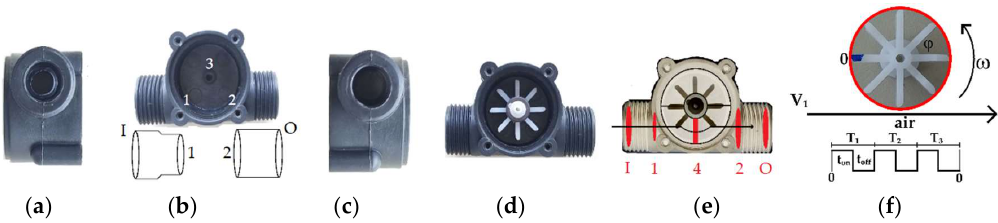
Figure 1. YF-S201 flow sensor: ( a ) Input profile; ( b ) Control volume; ( c ) Output profile; ( d ) Propeller compartment; ( e ) Airflow profile; ( f ) Detail of the propeller.